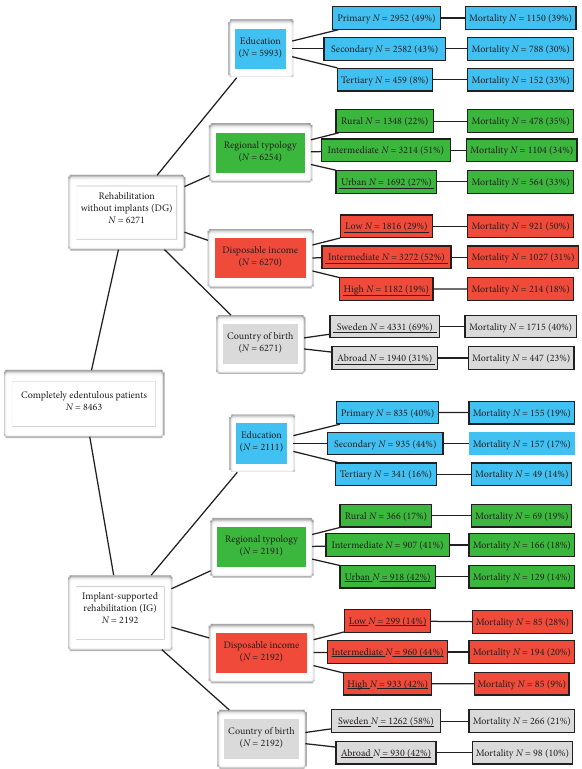
Figure 4: Flowchart of included edentulous